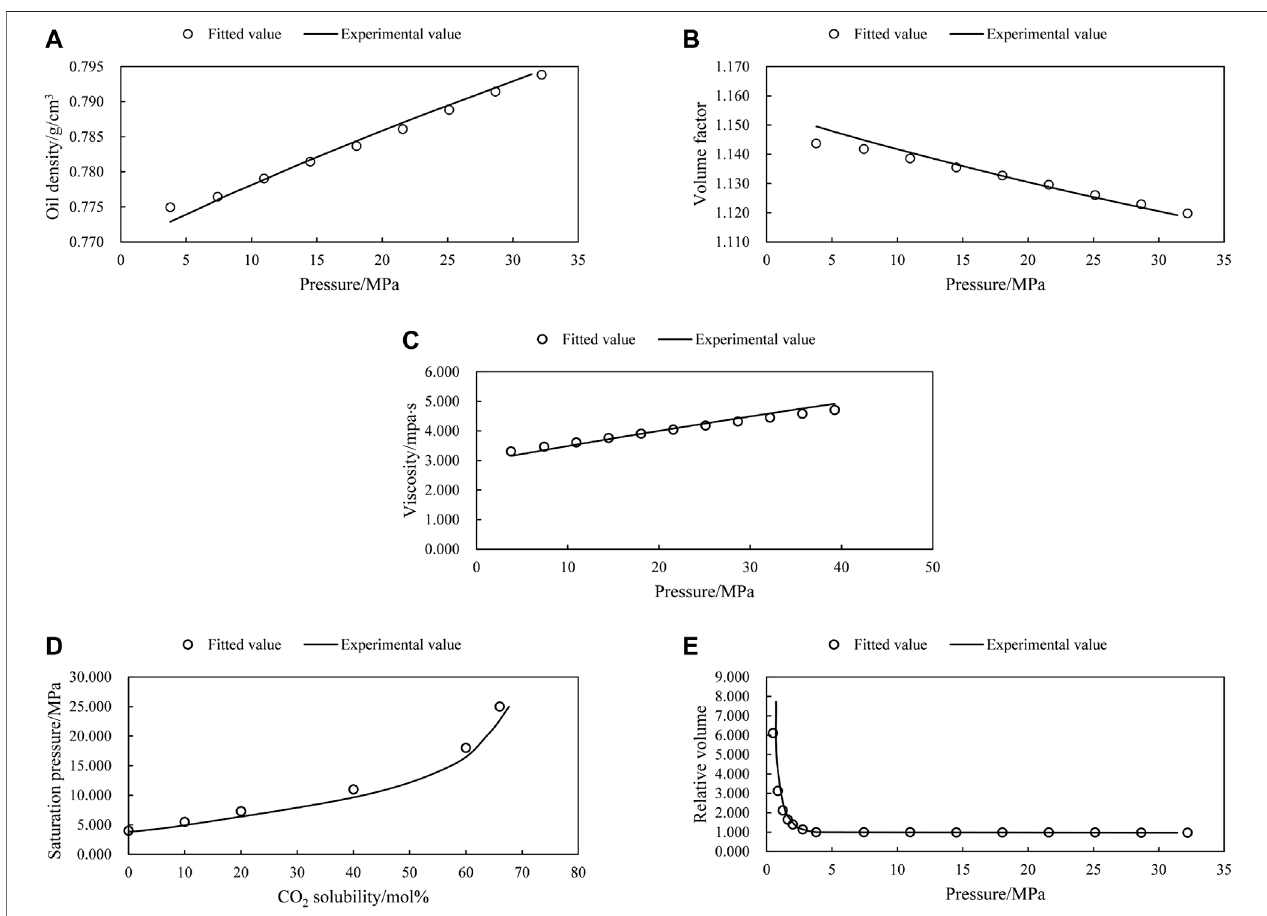
FIGURE 3 | (A) Oil density fi tting; (B) volume factor fi tting; (C) viscosity fi tting; (D) saturation pressure fi tting; (E) relative volume fi